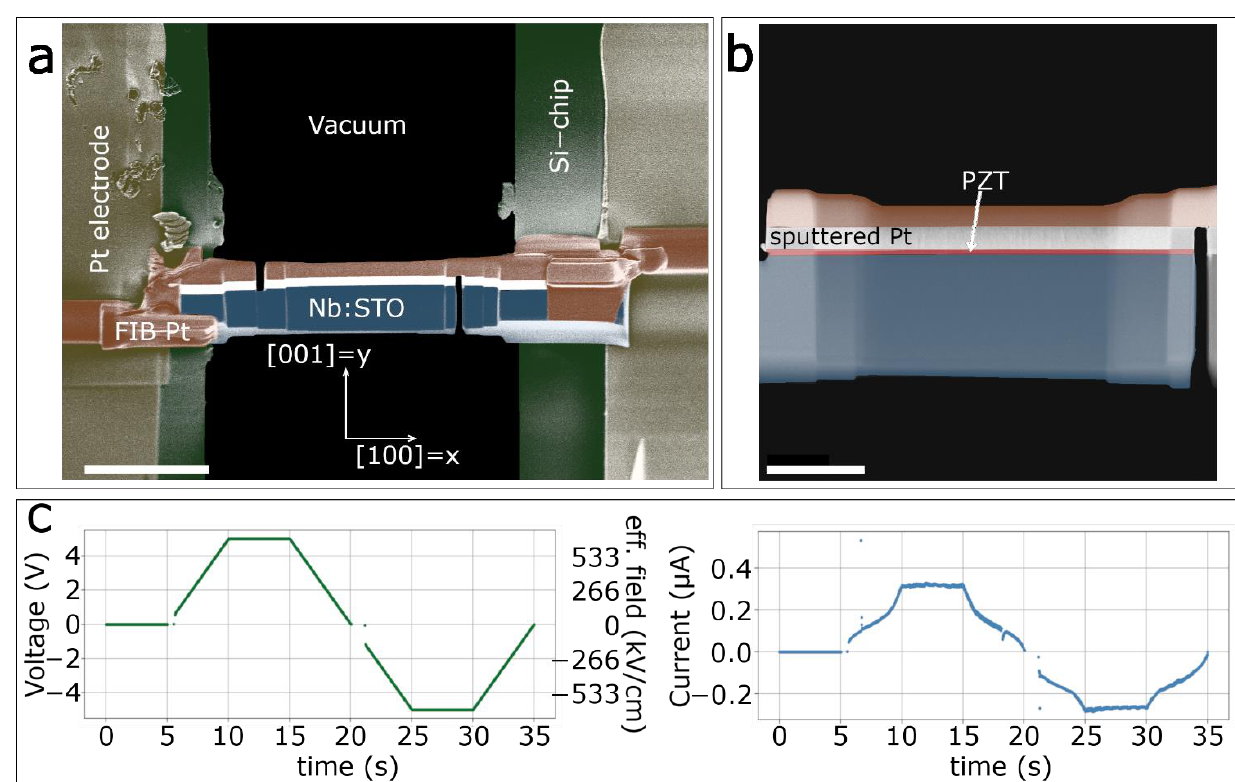
Figure 1. ( a ) False colored scanning electron microscopy (SEM) image and ( b ) false colored high-angle annular dark-field scanning transmission electron microscopy (HAADF-STEM) image of a lamella for in situ biasing prepared by focused ion beam (FIB). Yellow: Pt electrodes of the microelectromechanical systems (MEMS) chip. Orange: FIB-deposited Pt. Green: Si-MEMS chip, Blue: Nb-doped SrTiO 3 (Nb:STO) substrate. Red: Pb(Zr 0.2 Ti 0.8 )O 3 (PZT) thin film. The scale bars are 5 µm and 2 µm, respectively. ( c ) Applied voltage and measured current profiles during the in situ biasing experiments.